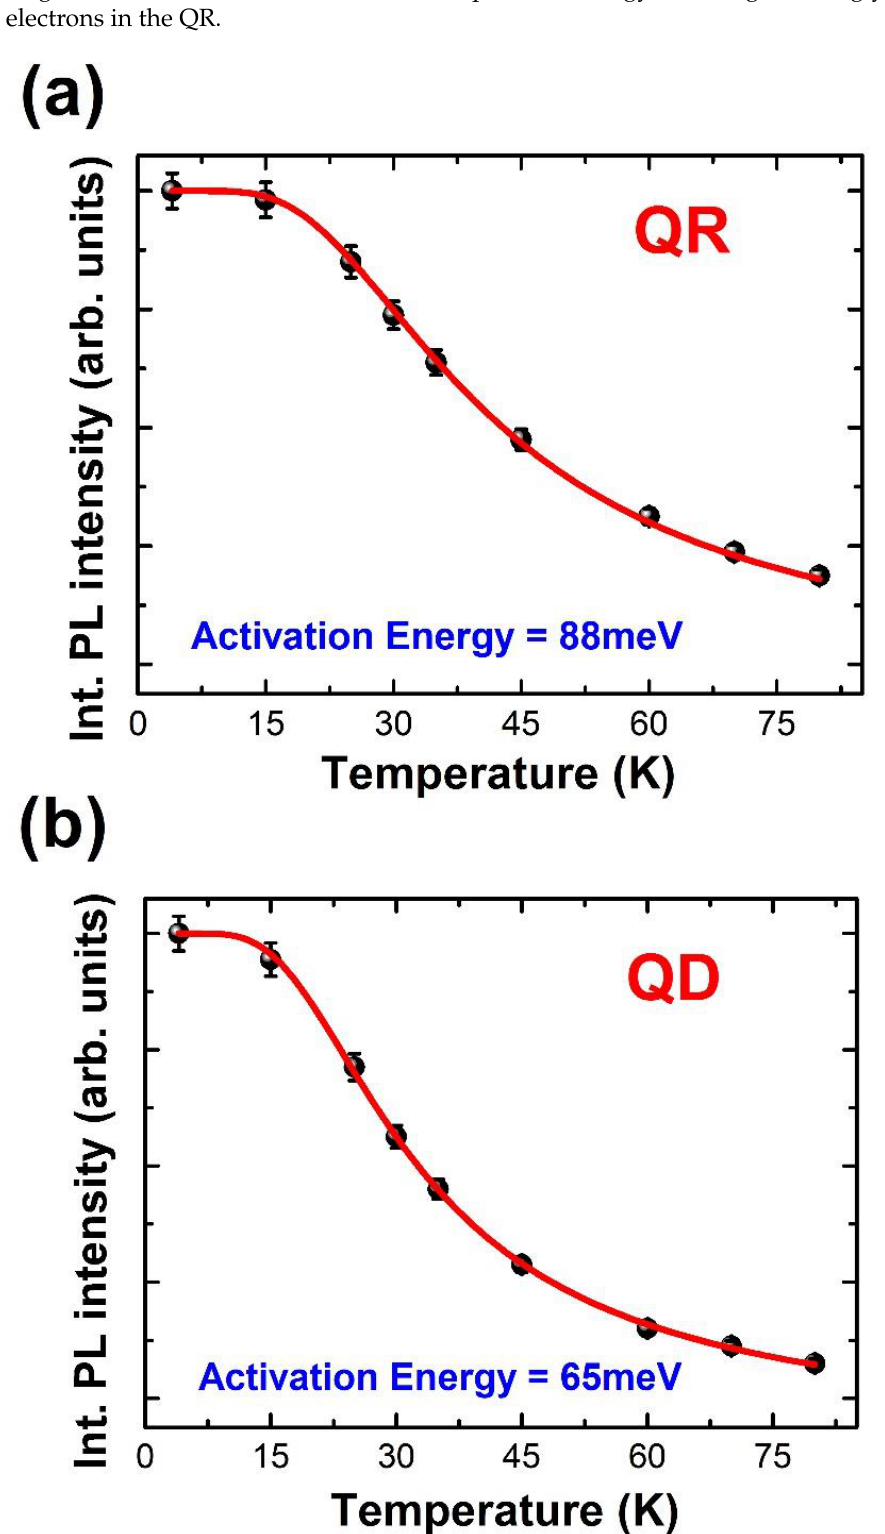
Figure 3. Integrated PL intensities with respect to the temperature for the ( a ) QR and ( b ) QD.